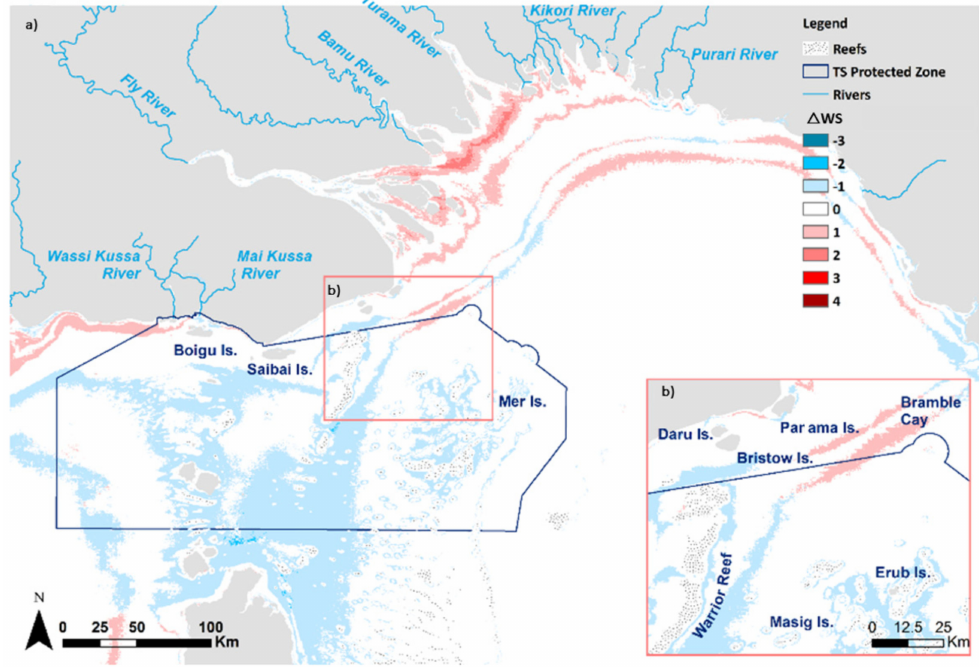
Figure 5. ( a ) Decadal seasonal difference map illustrating areas with an increase (red, positive turbidity anomaly) or decrease (blue, negative turbidity anomaly) in relative turbidity during the SE trade wind season against the monsoonal patterns. ( b ) Zoomed in map of Daru Island and the northern Warrior Reef. The seasonal difference map is calculated by subtracting the decadal median SE trade wind map to the decadal median monsoonal map (Table 3). ∆ WS is the difference in WS colour class category, with relative turbidity levels assumed to decrease from WS1 to WS7 ([22],